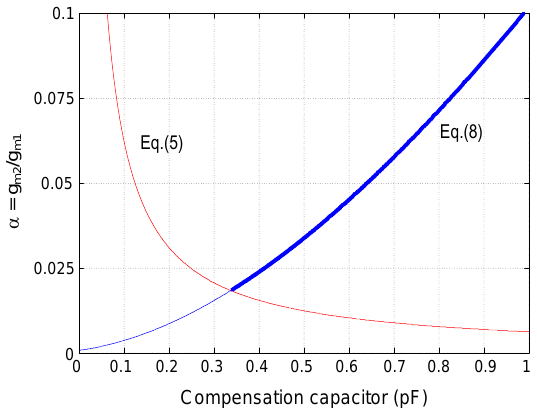
Figure 6. Transconductance ratio versus compensation capacitor in the FCCFN